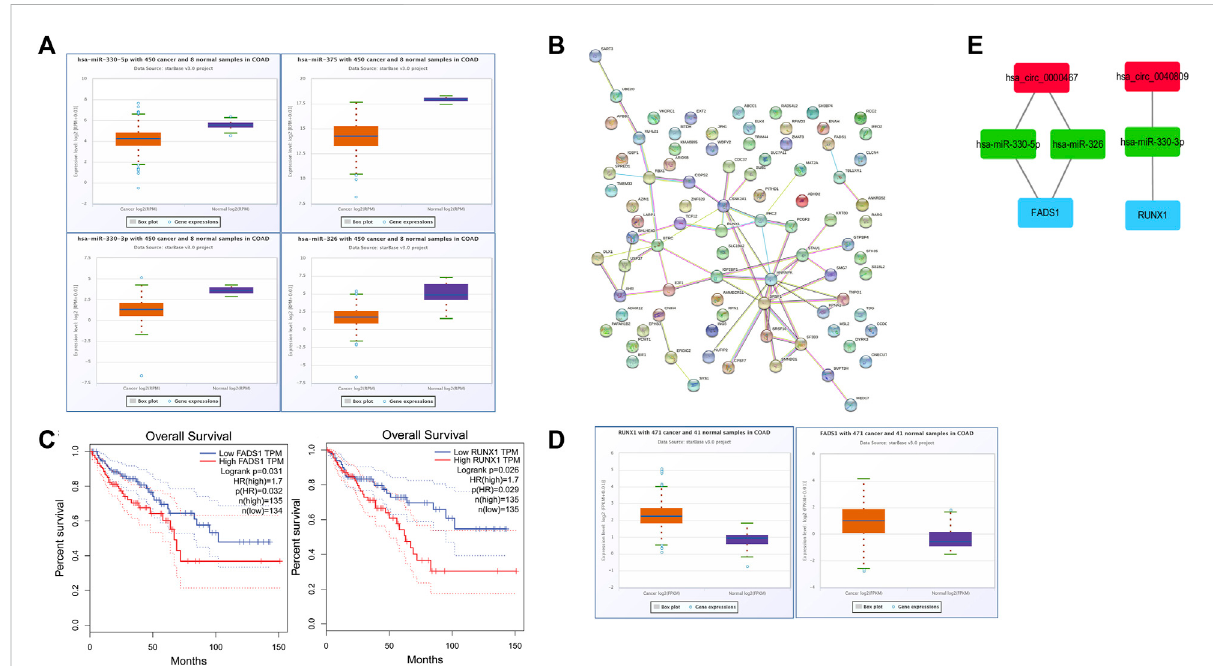
FIGURE 4 Bioinformatics analysis and aonstruction of circRNA-miRNA-mRNA network. (A) The expression of miR-330-3p, miR-330-5p, miR-326, and miR-375 in CRC from ENCORI. (B) A protein-protein interaction (PPI) network of 86 mRNAs. (C) The expression of FADS1 and RUNX1 in CRC from ENCORI. (D) Overall survival curves of FADS1 and RUNX1 from GEPIA. (E) A circRNAs-miRNAs-mRNAs